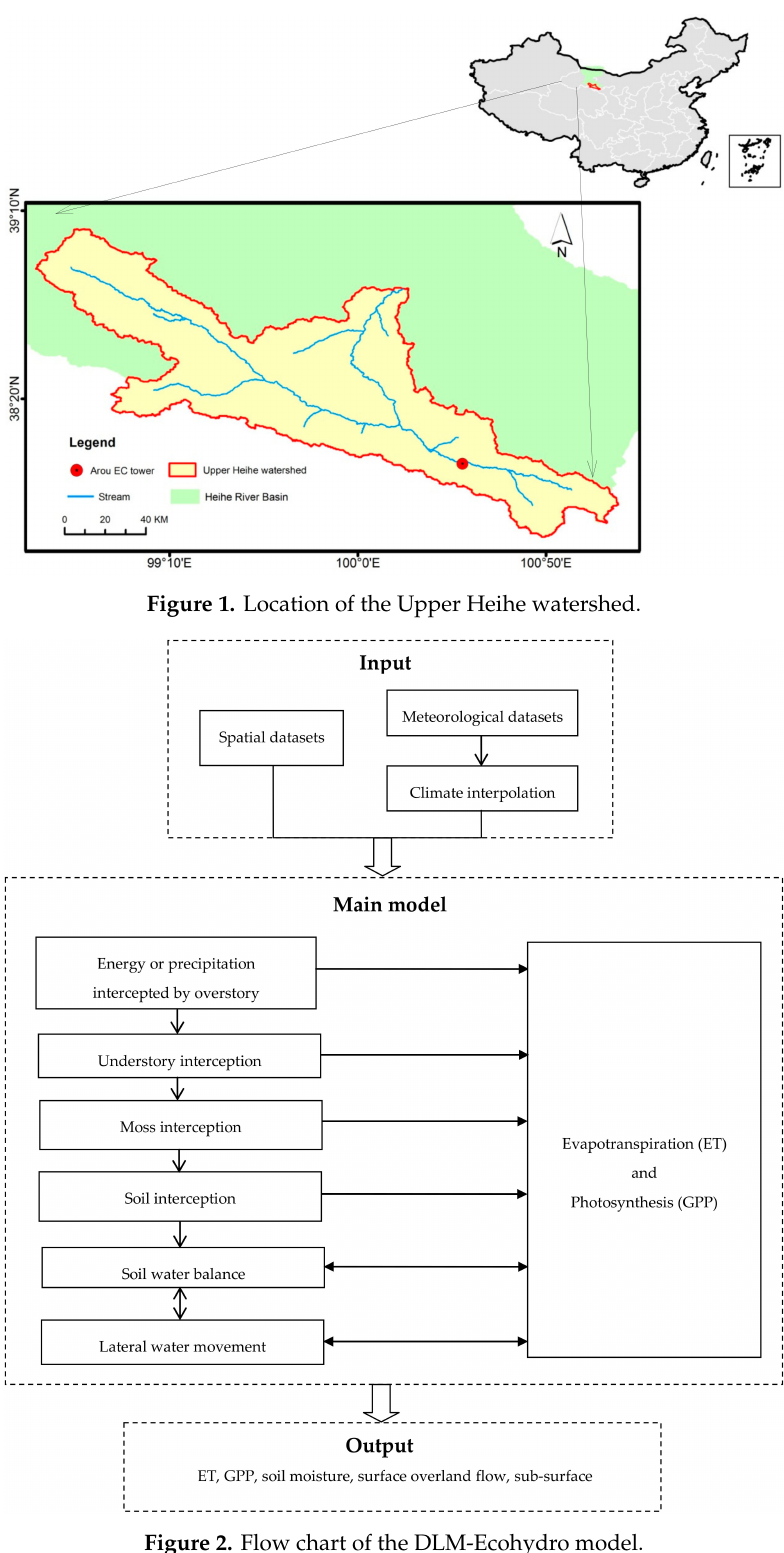
Figure 2. Flow chart of the DLM-Ecohydro